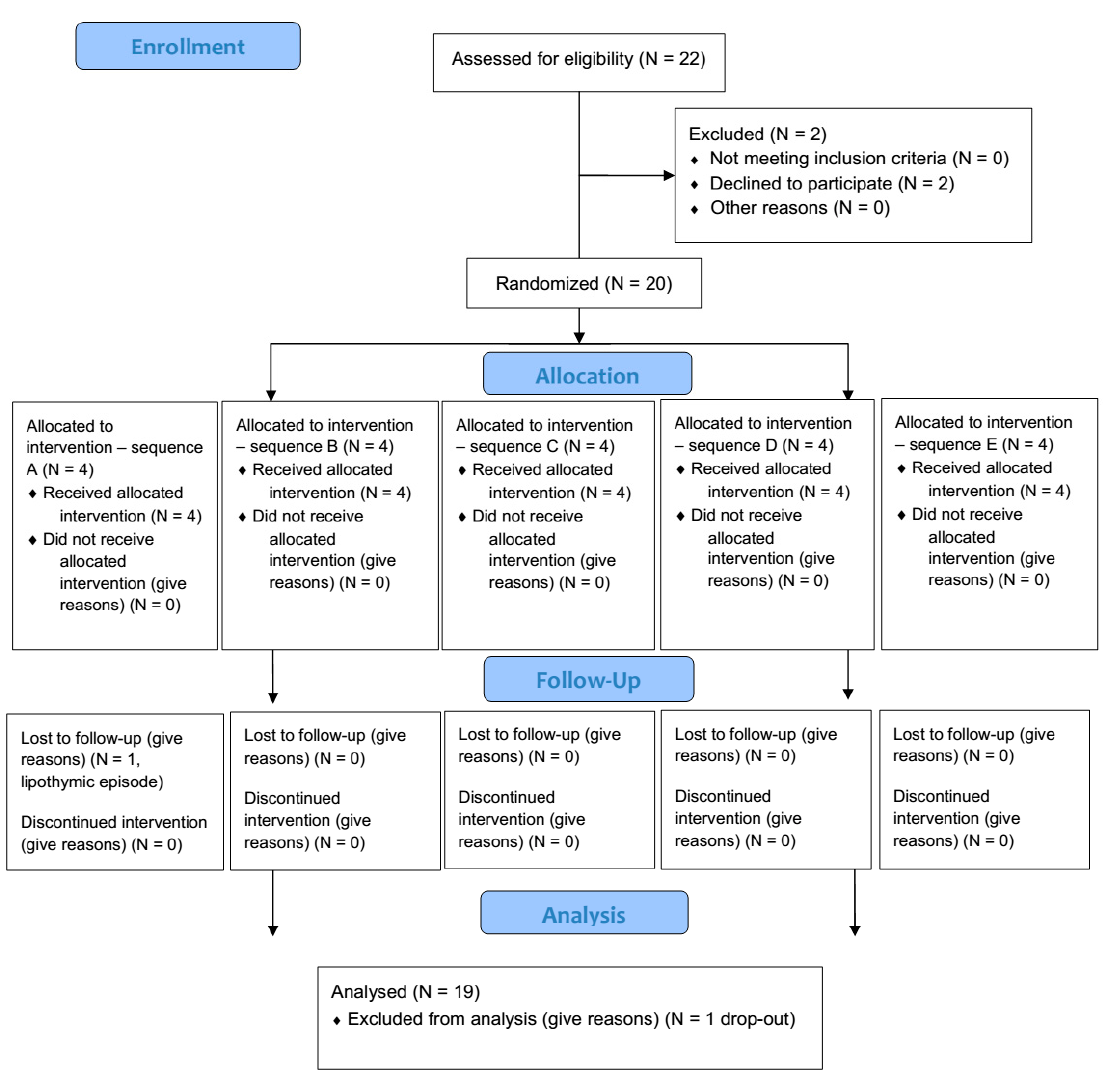
Figure 1. CONSORT (consolidated standards of reporting trials) flowchart of the study design.